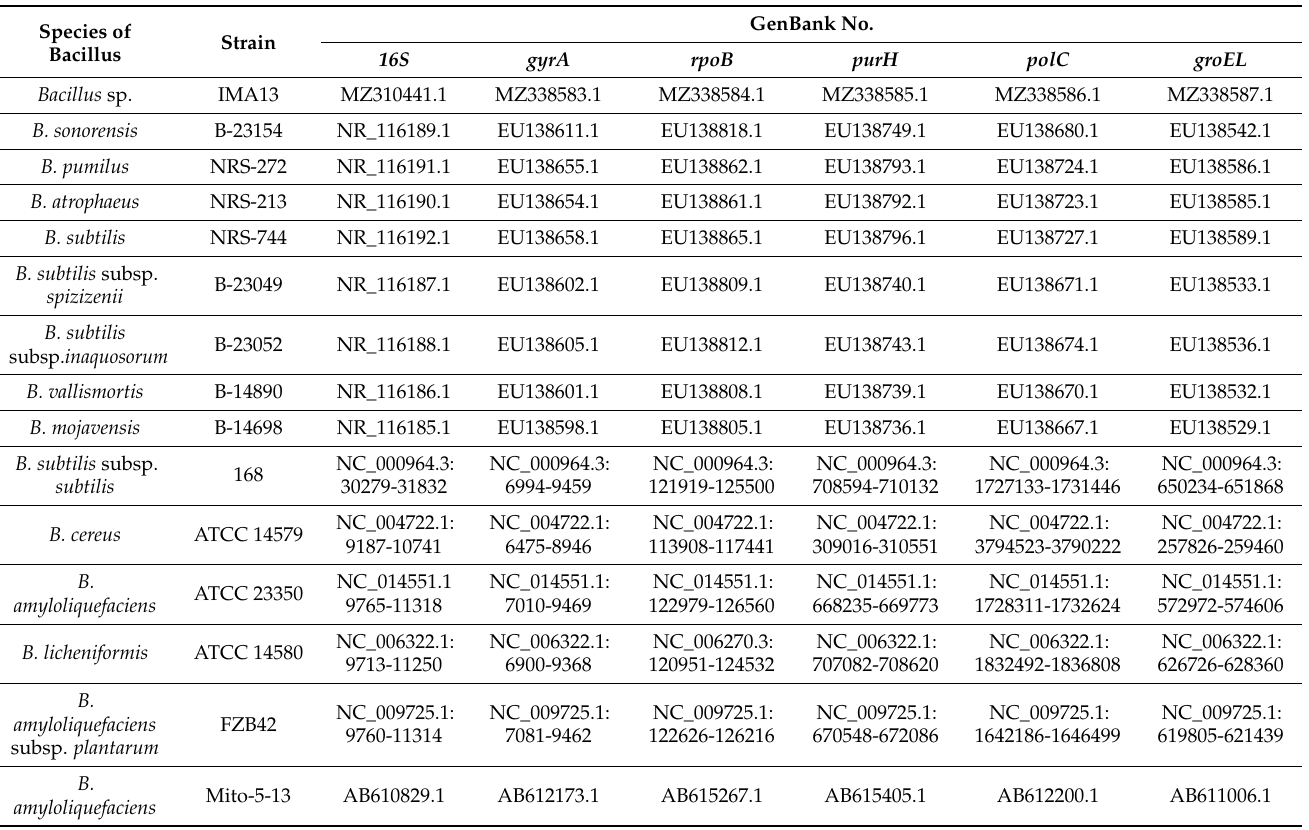
Table 2. The Bacillus strains used for the phylogenetic